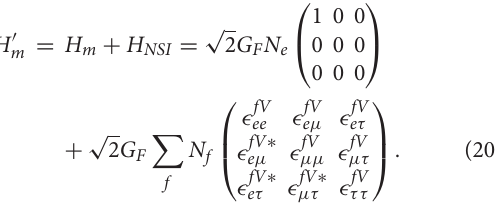
ν c ) where ν c P ( ν c →